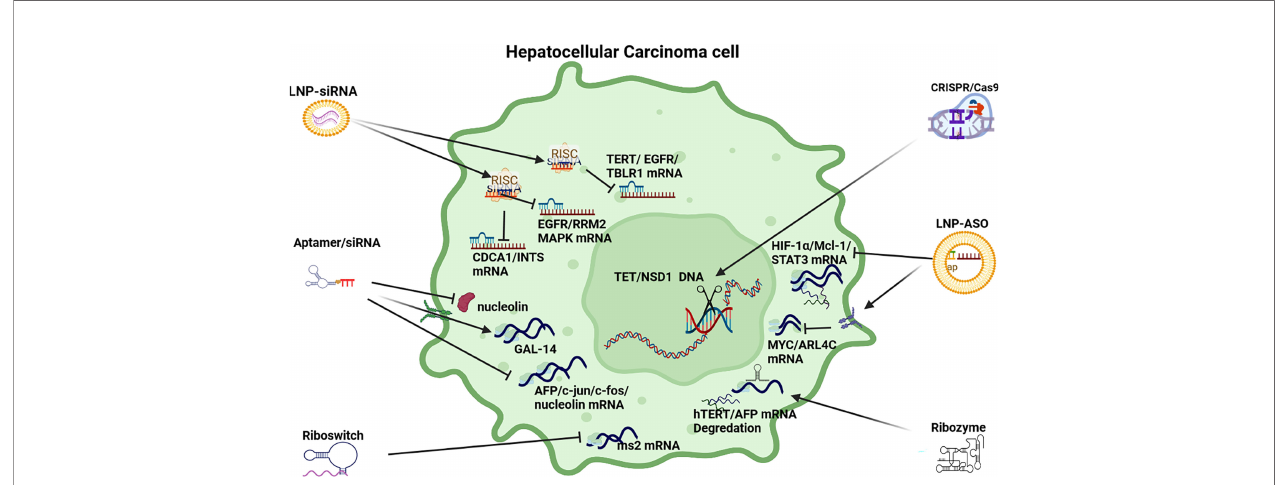
FIGURE 4 | RNAi anti-cell proliferation strategies. LNP-siRNA (Lipid nanoparticles for targeted small interfering RNA delivery), CRISPR/Cas9 V (clustered regularly interspaced short palindromic repeats/CRISPR-associated protein 9), LNP-ASO (lipid nanoparticle associated antisense oligonucleotide), siRNA (small interfering RNA). HIF-1 a /Mcl-1/STAT3 (hypoxia-inducible factor 1-alpha, a subunit of a heterodimeric transcription factor hypoxia-inducible factor 1 that is encoded by the HIF1A gene/induced myeloid leukaemia cell differentiation protein gene/signal transducer and activator of transcription 3), MYC/ARL4C (transcription factor, proto- oncogene/ADP-ribosylation factor-like 4C), hTERT/AFP (human telomerase reverse transcriptase/alpha fetoprotein), AFP/c-Jun/c-fos/nucleolin (transcription factors), GAL-14 (galectin 14), CDCA1/INTS (Cell division cycle associated 1, an oncoantigen), EGFR/RRM2/MAPK (epidermal growth factor receptor/ribonucleoside- diphosphate reductase subunit M2/mitogen-activated protein kinase), TERT/EGFR/TBLR1 [telomerase reverse transcriptase, a catalytic subunit of telomerase/ transducin (beta)-like 1 X-linked receptor